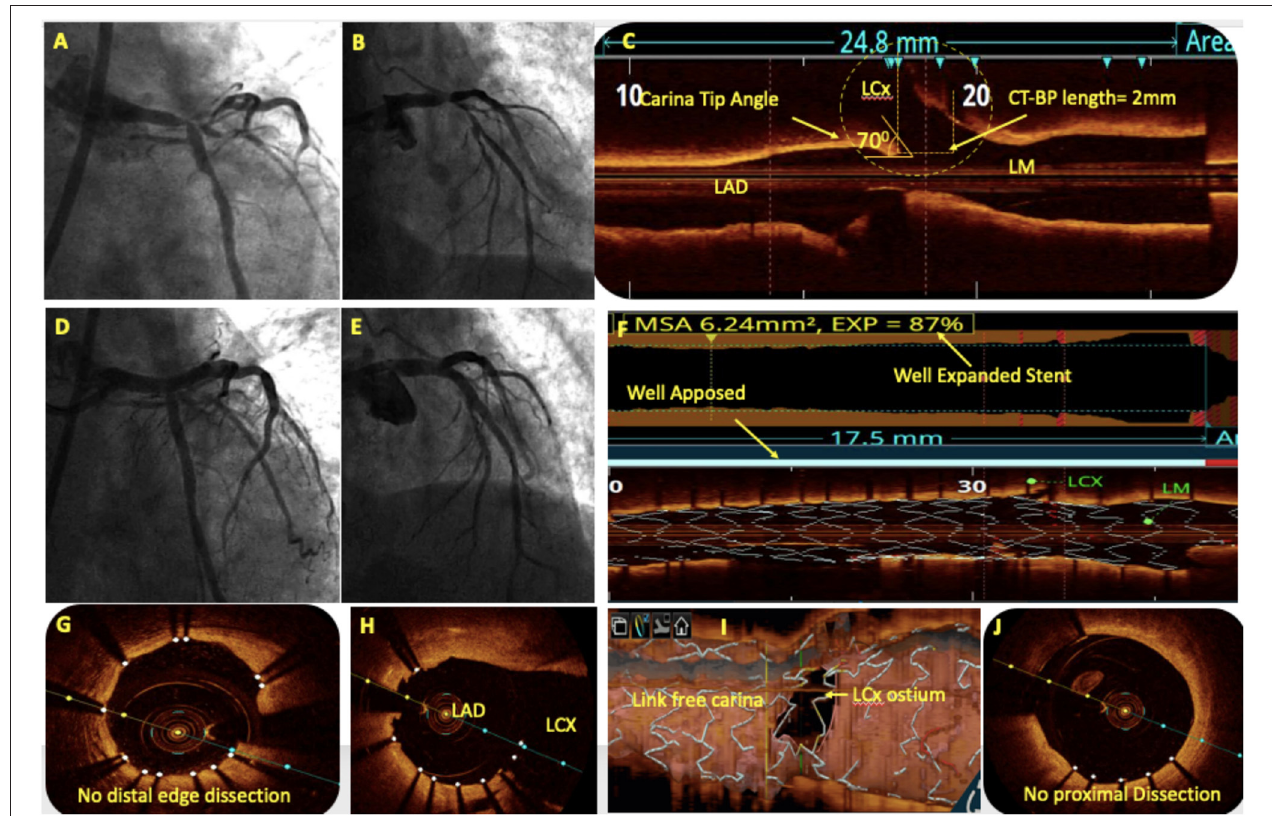
FIGURE 6 | OCT in bifurcation angioplasty. (A,B) Coronary angiography showed a significant left main (LM) bifurcation lesion (Medina 1.1.1). (C) Pre-PCI OCT showed the carina tip (CT) angle of 70 ◦ and CT to bifurcation point (CT-BP length) of 2mm suggestive of bifurcation lesion suitable for provisional stenting without the risk of side branch (SB) compromise. (D) An OCT-guided LM-LAD cross-over stenting was done followed by the proximal optimization technique (POT) with balloons of appropriate size. (E) Post-PCI angiography showed TIMI III flow in left coronary system without LCx compromise. Post-PCI OCT showed well-apposed stent with 87% expansion (F) , without proximal or distal edge dissection (G,J) and minimal stent struts across LCx ostium (H) . 3D reconstruction showed minimal inappropriate stent apposition across LCx ostium with link-free carina (I)